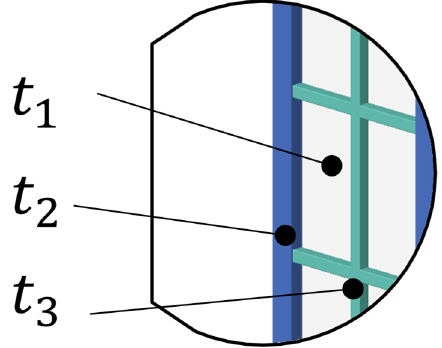
9 of 17 Figure 8. Radial expansion of containment boundary.